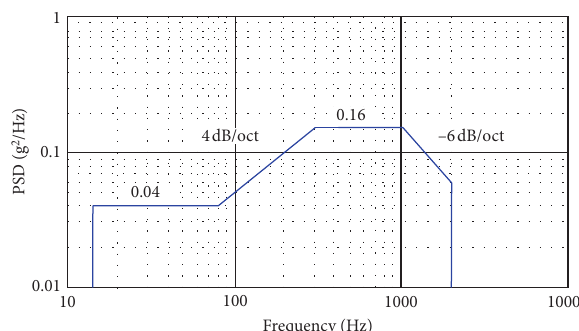
Figure 12: Random load spectrum of pipeline in aircraft.